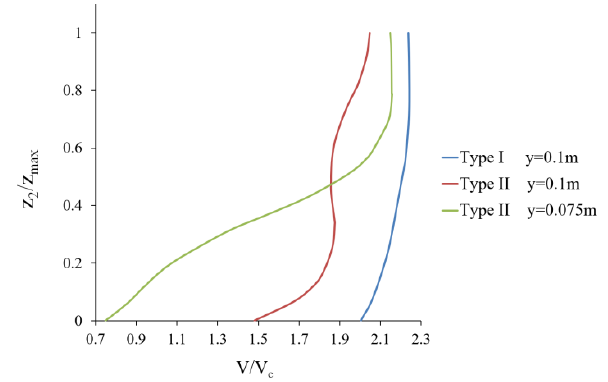
Figure 12. Section flow velocity distribution of different types of steps.